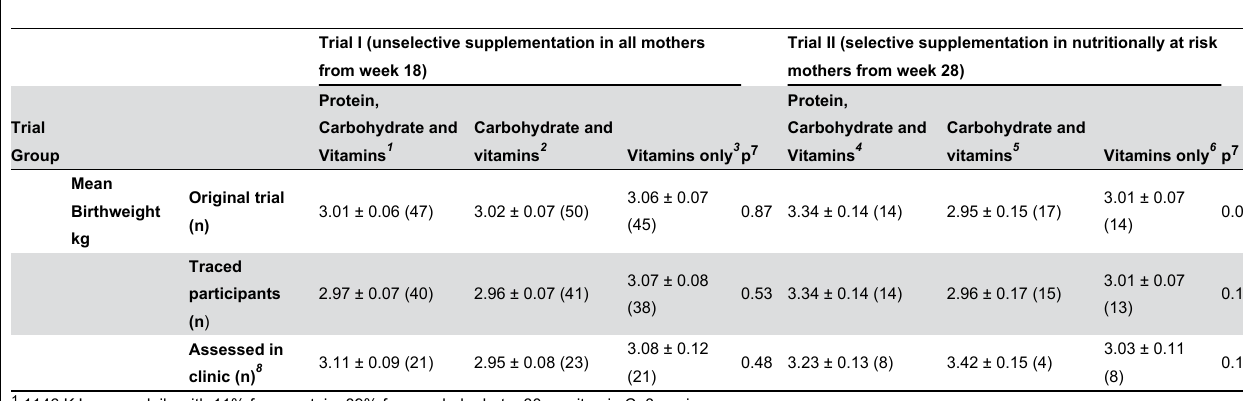
Table 2. Trial Allocation and birthweight in the Sorrento studies of maternal nutritional supplementation (values are mean ±